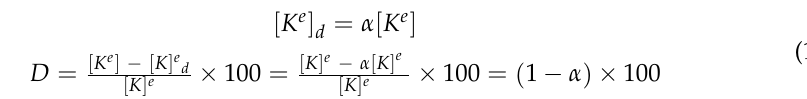
Table 2. Four damage scenarios for structural health monitoring. Scenarios No.